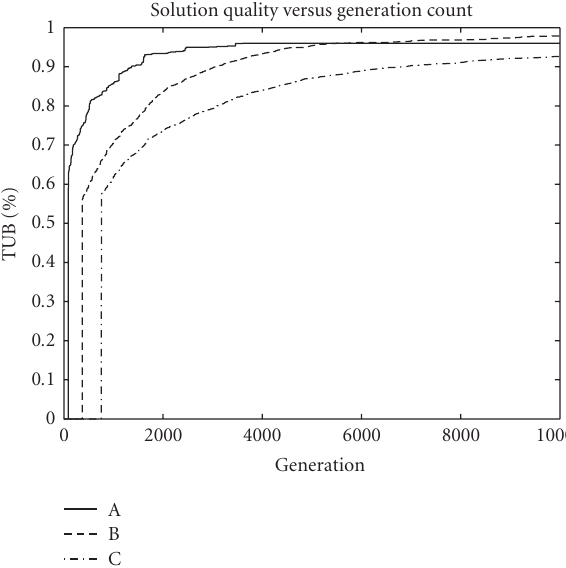
Figure 7: Solution Quality versus Generation Count, single run of algorithm over 10 000 generations. Values of zero indicate that the population was comprised of infeasible solutions. All three trajectories were created using proportional selection paired with the dynamic penalty strategy. Figure 7 graphs solution quality against generation